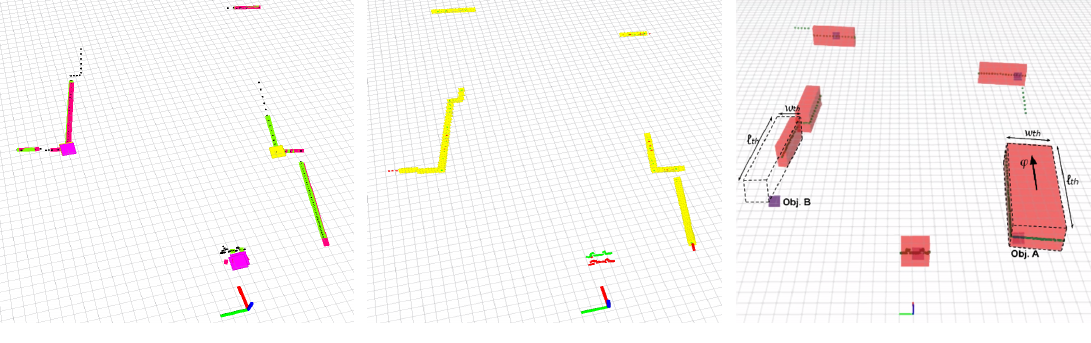
Figure 5. Objects detected and extracted geometric primitives. ( a ) shows segmented elements from two overlapped scans Sc t and Sc t − k and their respective lines and corners extracted. Green lines and yellow corners belong to the actual scan Sc t , whereas purple lines and red corners are extracted from the past Sc t − k scan. We can clearly appreciate how corners and lines are representative features, being corners more reliable. ( b ) shows in yellow the segmented objects matched, so that considered as static. A dynamic detected object in the middle is shown without a match, and both previous and current scans can be appreciated in red and green, respectively. ( c ) represents the features extracted from detected objects, where we can observe the reference propagation of Obj. B . Best viewed in